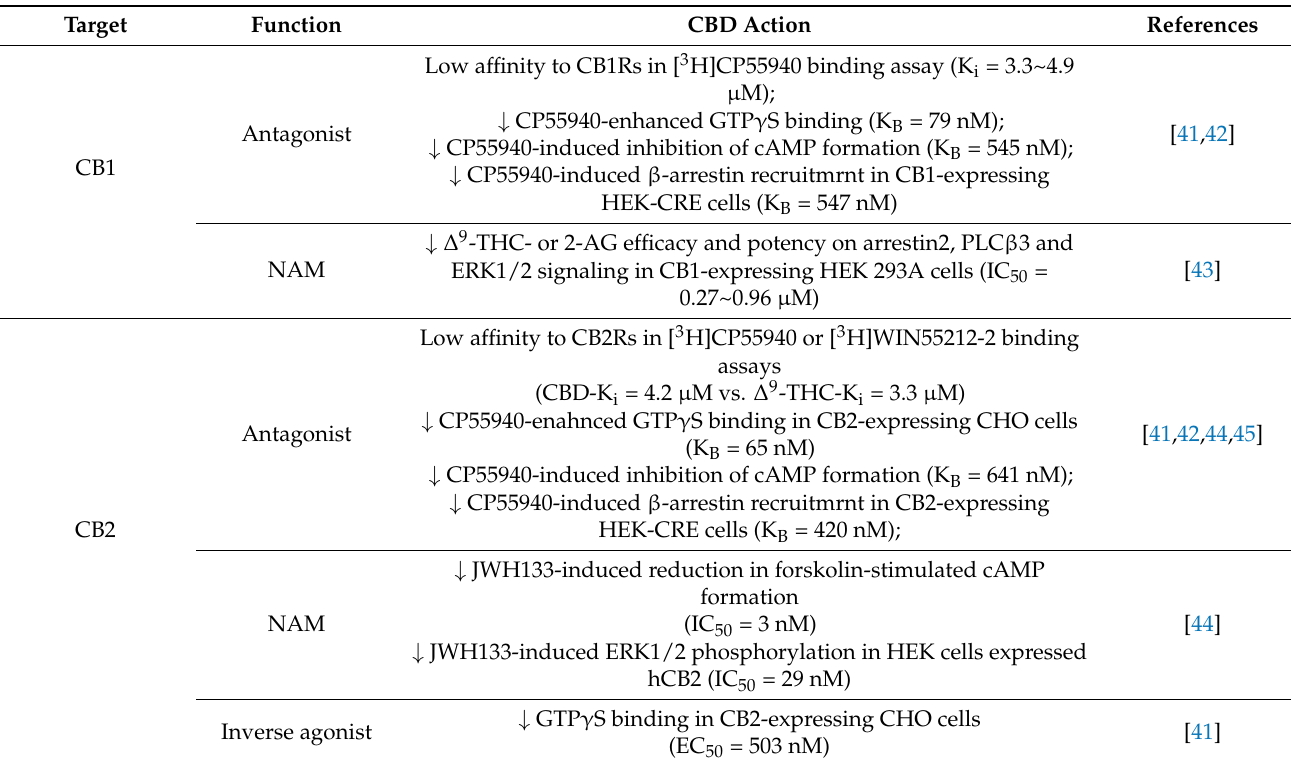
Table 1. Cannabidiol (CBD) binding profiles in in vitro binding assays for the receptors or functional molecules involved in drug abuse and addiction.